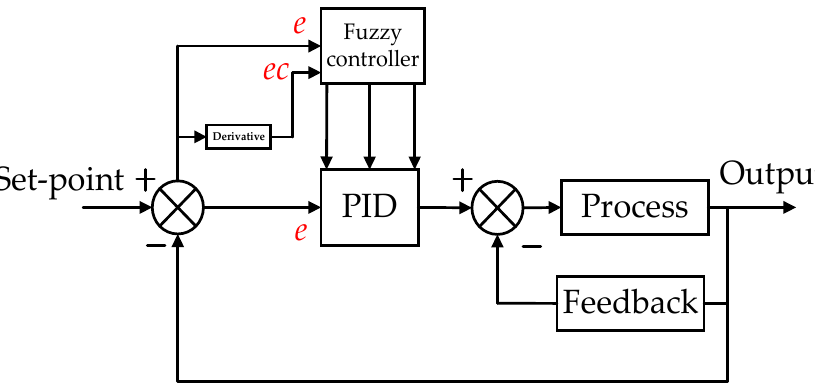
= proportional integral Figure 4. Fuzzy PID (FPID) control system. Figure 4. Fuzzy PID (FPID) control system. Note: PID Figure 4. Fuzzy PID (FPID) control system.